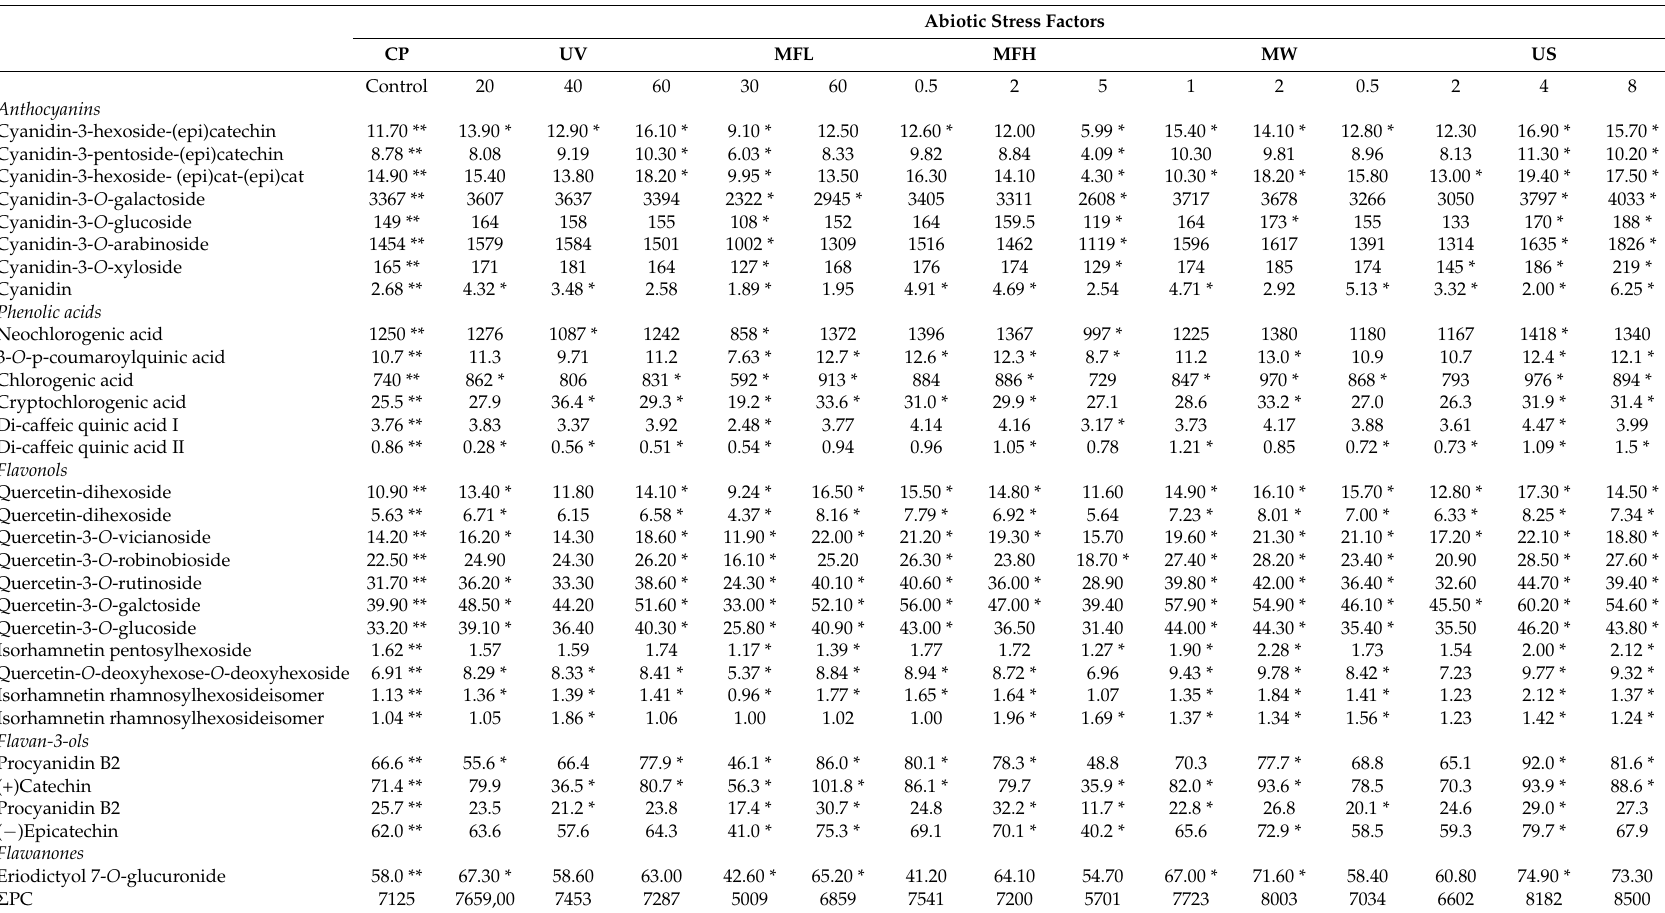
Table 1. The influence of abiotic stress factors (UV-C electromagnetic field of the microwave field, ultrasound) on the content of individual polyphenolic compounds in chokeberry fruits, mg/100 g dm ( n =